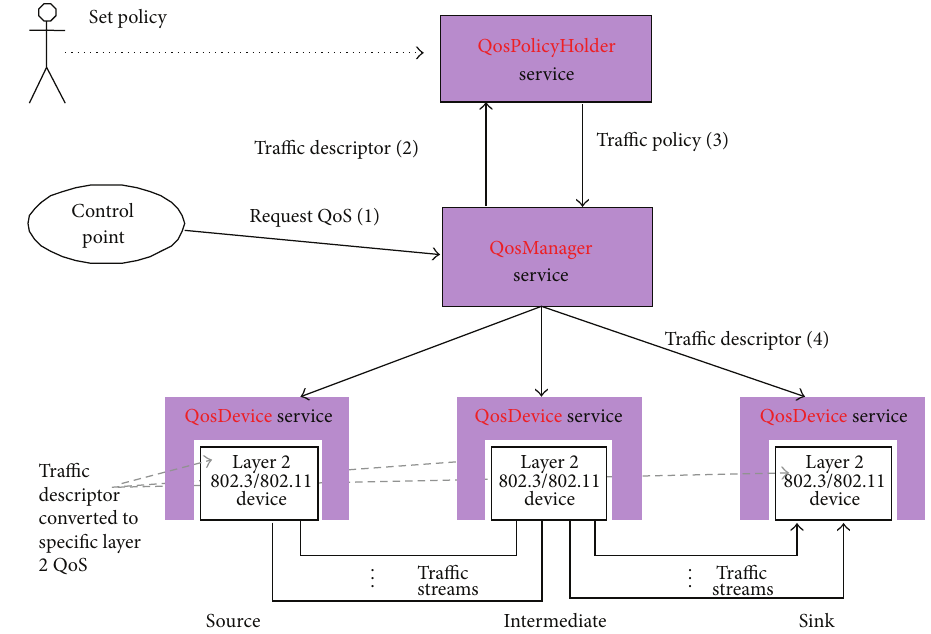
Figure 7: UPnP-QoS architecture averview [7, Figure 1